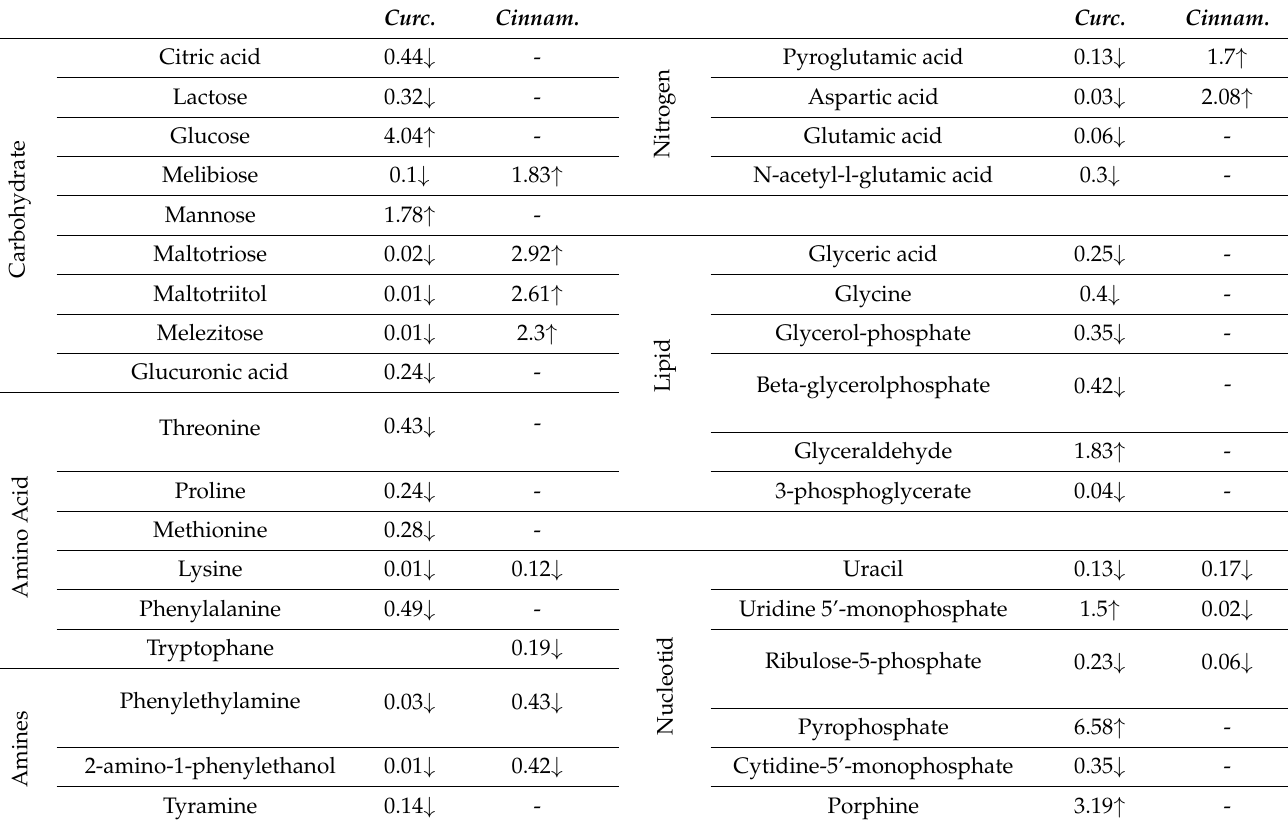
Table 2. Comparison of metabolic profiling of P. aeruginosa biofilm cells treated with ciprofloxacin alone and combinations of ciprofloxacin with curcumin and cinnamaldehyde. The biofilm cells were grown in brain heart infusion agar (BHI) broth at 37 ◦ C for 24 h, followed by further treatment with antimicrobial agents for another 24 h. The results are shown as the average. Curc. Cinnam. Curc.